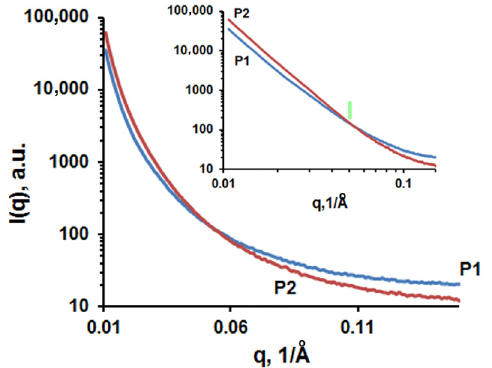
Figure 6. The scattering curves I(q) (log-norm plot) for samples obtained from W/A (P1—sample 13, Table S3) and DMF (P2—sample 7, Table S1), and inset—the logarithmic plot of the scattering curves. The green arrow indicates the end of the linear region corresponding to the same q value for both samples.